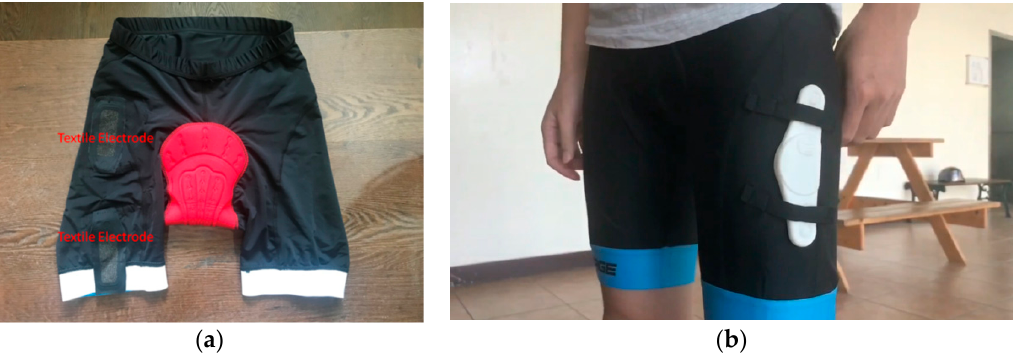
Figure 12. ( a ) Photo of the lining of the bicycle pants; ( b ) the EMG patch was placed on the bicycle pants to measure the lateral femoral muscle.